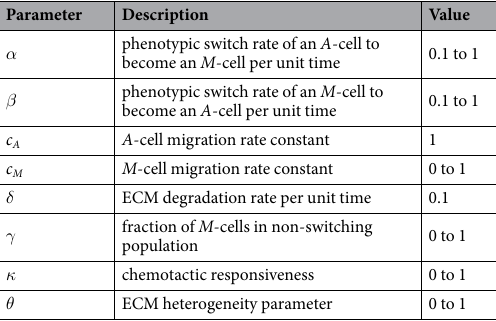
Table 2. Overview of all model